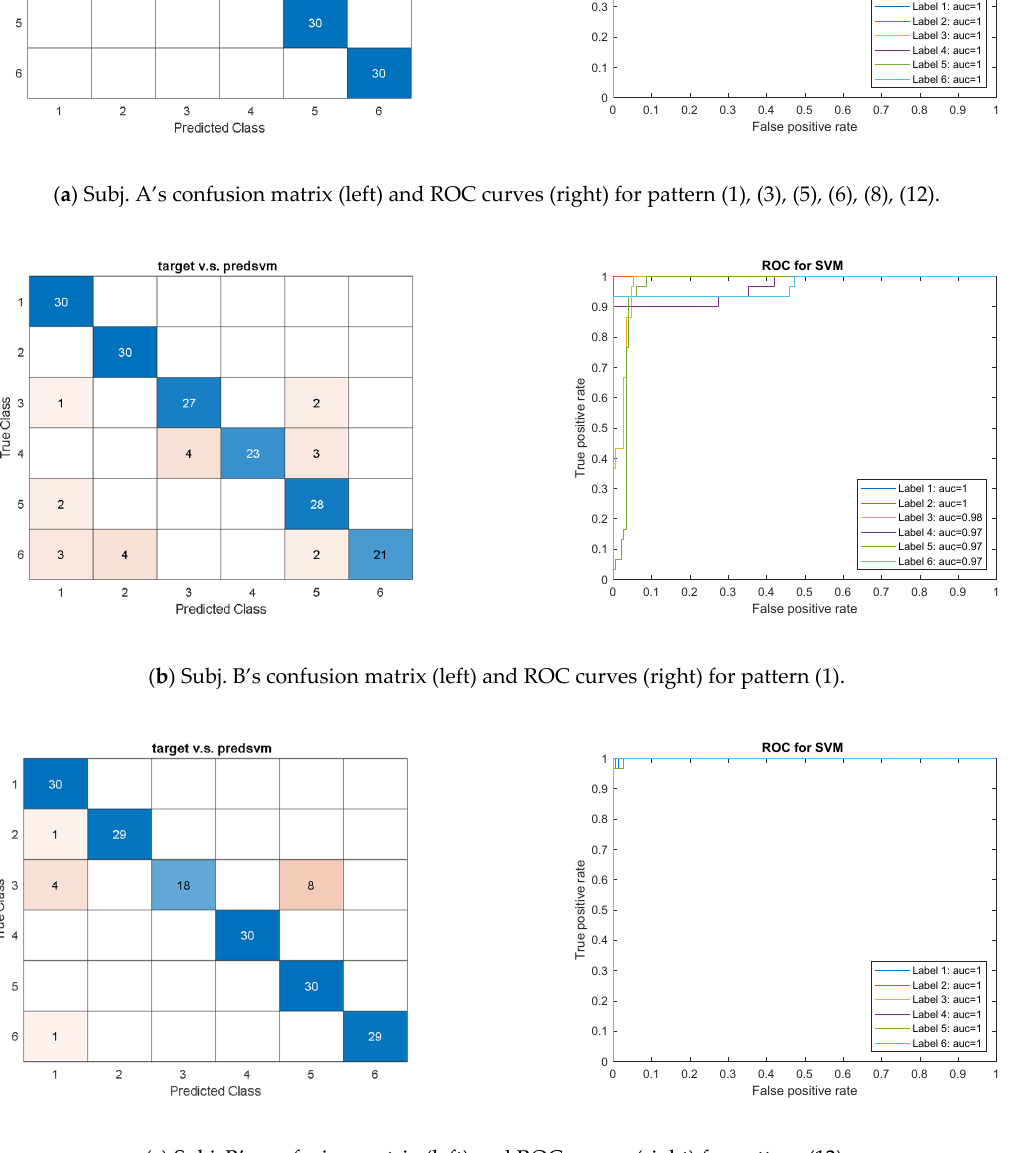
Figure 5. The confusion matrix and one-vs-rest ROC curves for validation dataset using the SVM model with ( a ) feature pattern (1), (3), (5), (6), (8), and (12) for Subject A, ( b ) feature pattern (1), and ( c ) feature pattern (12) for Subject B.